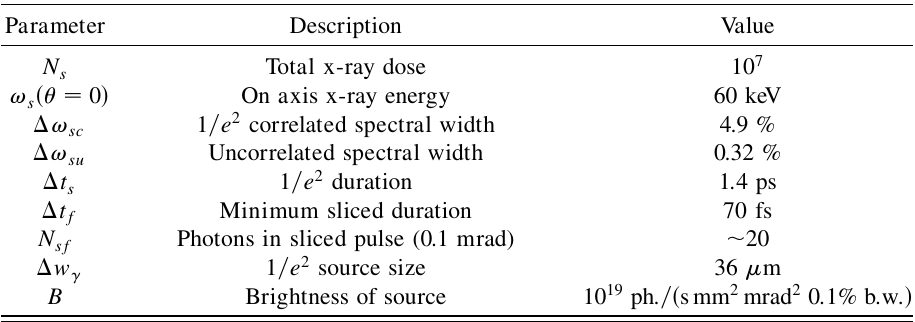
TABLE II. Chirped Thomson x-ray beam parameters. Parameter Description